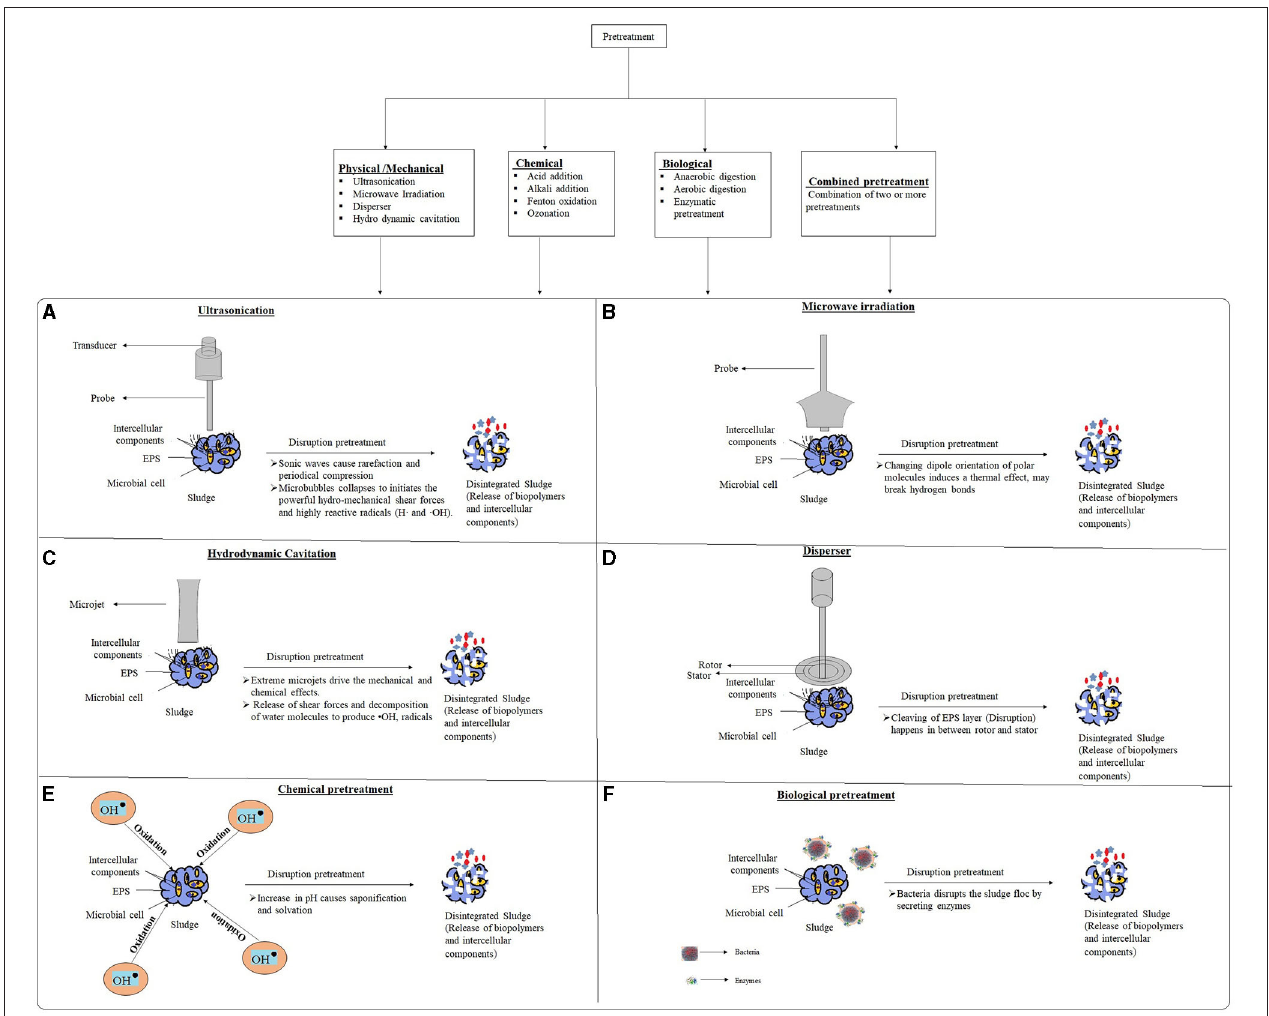
FIGURE 2 | Various pretreatment techniques and mechanisms for different pretreatment methods. (A) Ultrasonication, (B) microwave irradiation, (C) hydro dynamic cavitation, (D) disperser, (E) chemical, and (F) biological pretreatment (Adapted from Guan et al., 2018; Mancuso et al., 2020; Banu et al.,